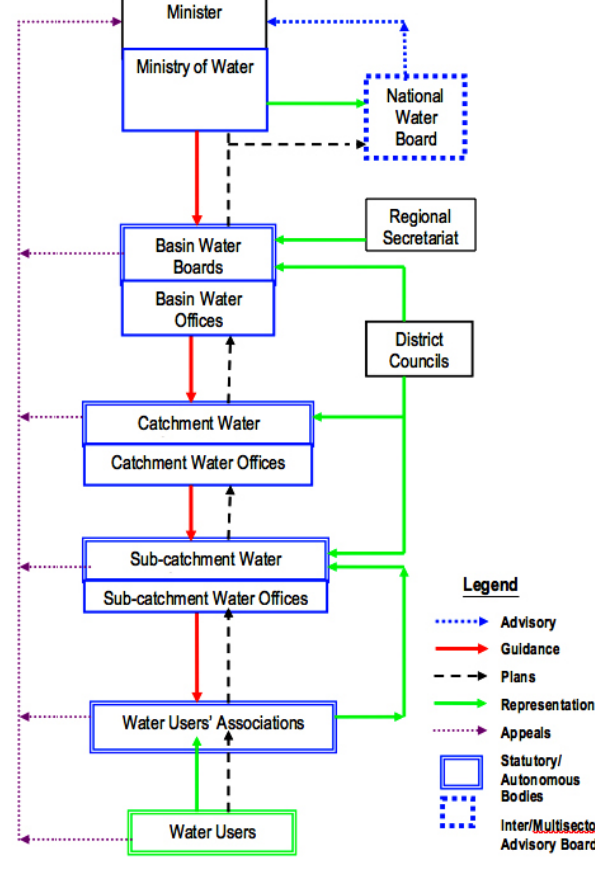
Fig. 2. Schematic of the institutional framework for freshwater resources management in Tanzania. Source: Tanzania Water Sector Development Programme 2006–2025, Tanzanian Ministry of